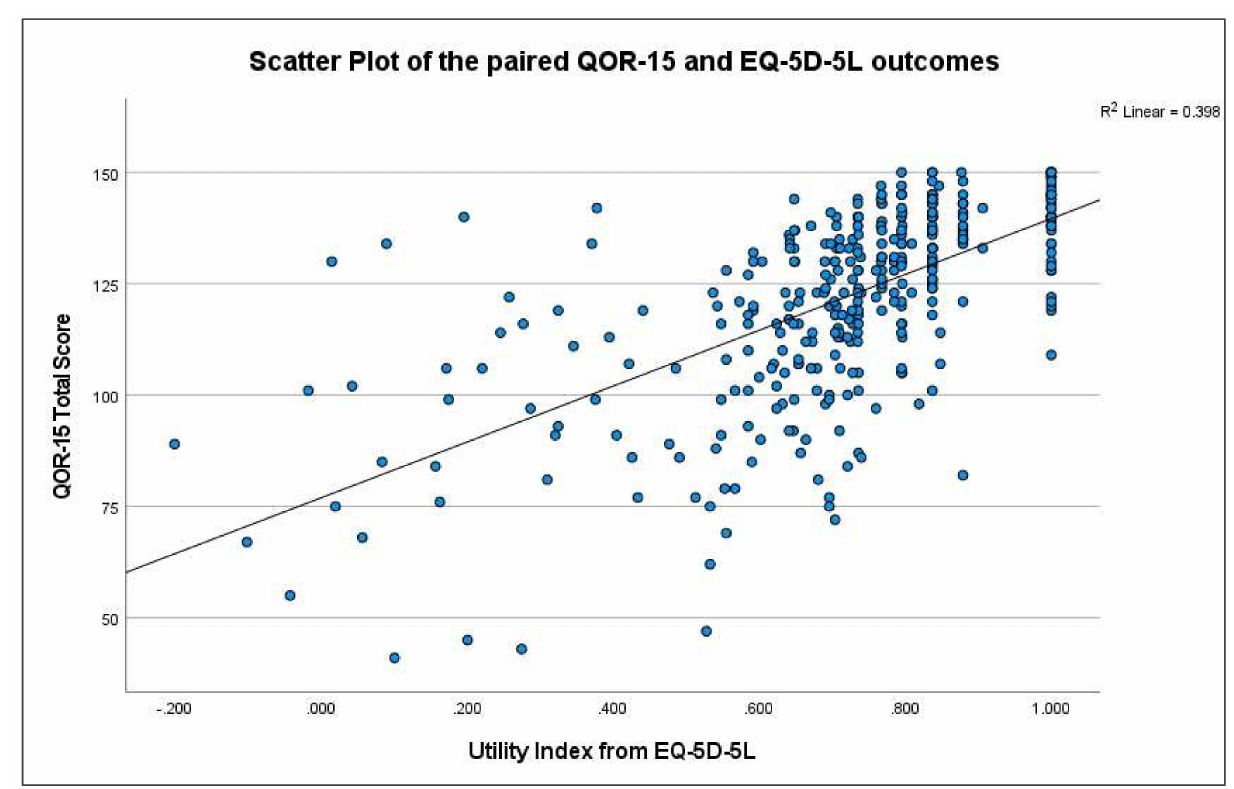
Figure 3. Scatter plot of the paired QOR-15 and EQ-5D outcomes. Table 4. Correlation values for individual domains present in both the QoR-15 and the EQ-5D. Number Correlation Coefficient # p